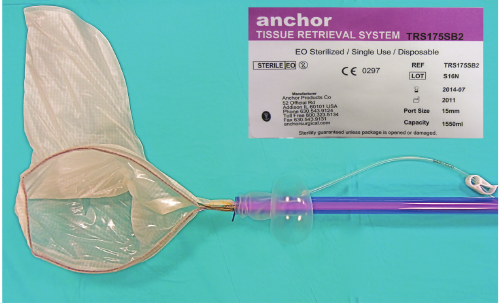
Figure 4: Anchor bag expelled to obtain